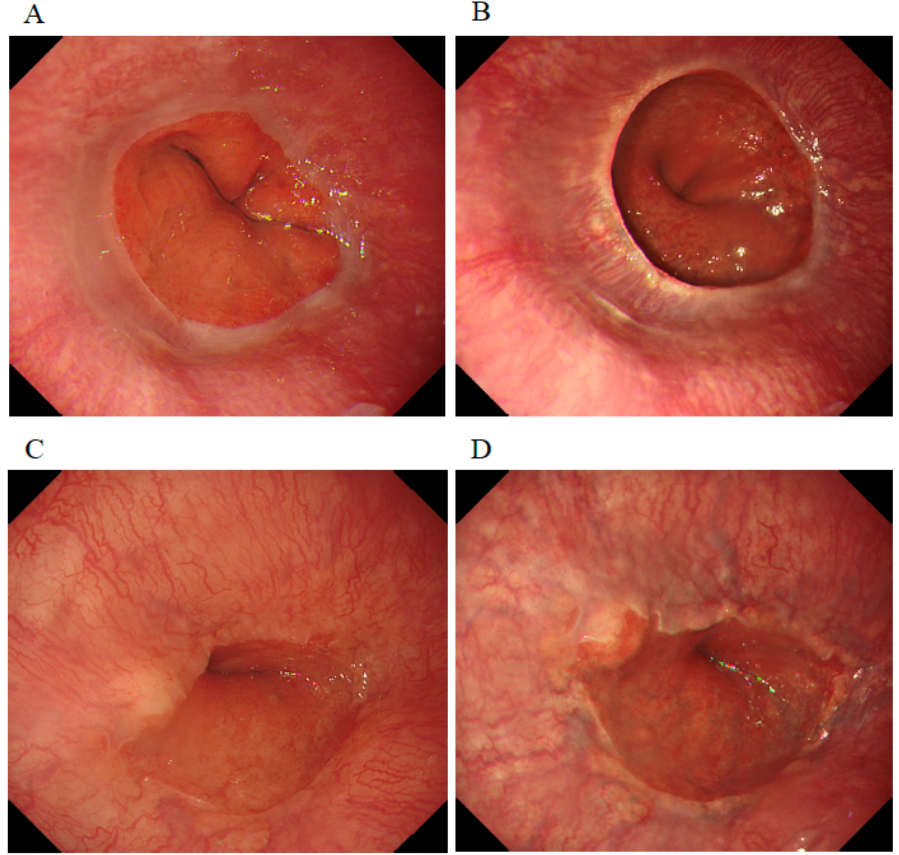
Figure 2. Typical endoscopic images in patients in which texture and color enhancement imaging (TXI) clearly showed GERD Grade M, whitish turbidity, in the esophagocardial junction compared to white-light imaging (WLI). Case 1, WLI ( A ) and TXI ( B ) and Case 2, WLI ( C ) and TXI ( D ). 3.3. Color Differences between SSBE and Gastric or Esophageal Mucosa The color differences ( ∆ E*) between esophageal and gastric mucosa were 15.7 ± 6.9 in WLI, 33.4 ± 11.8 in NBI, and 18.2 ± 8.3 in TXI, respectively (Table 3). Although the color difference between esophageal and gastric mucosa was similar between WLI and TXI, this difference was significantly greater in NBI ( p < 0.001 and p <